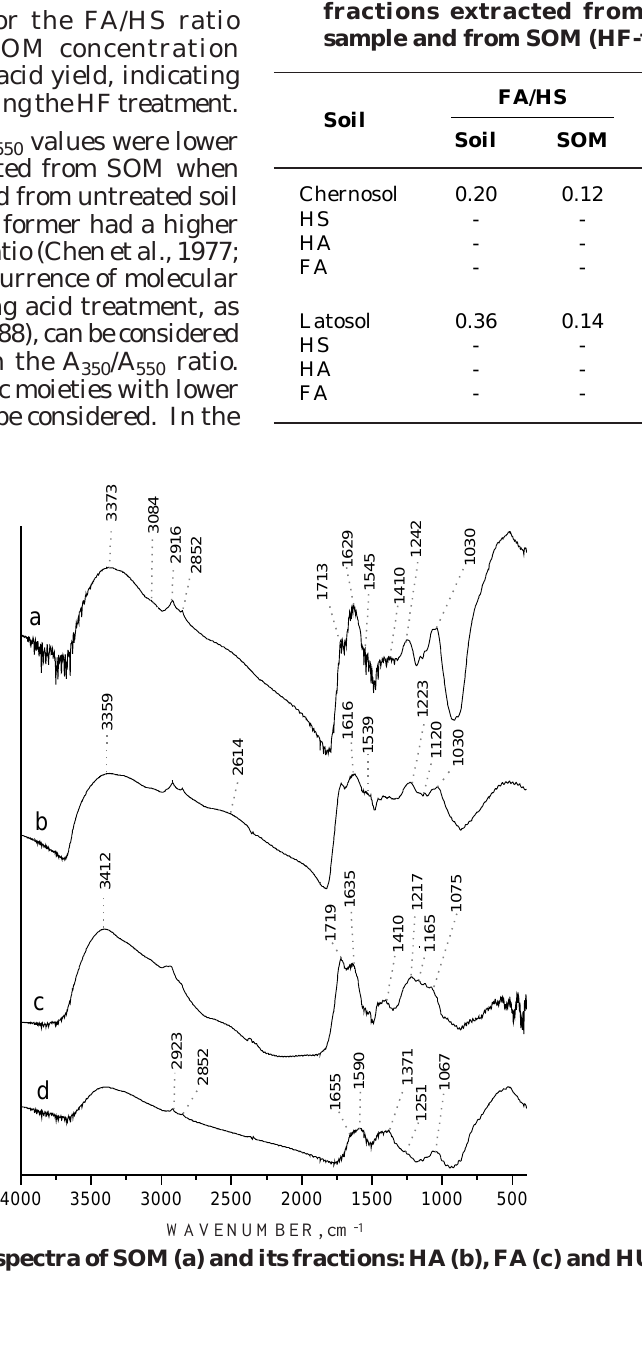
/A ratios of humic 350 550